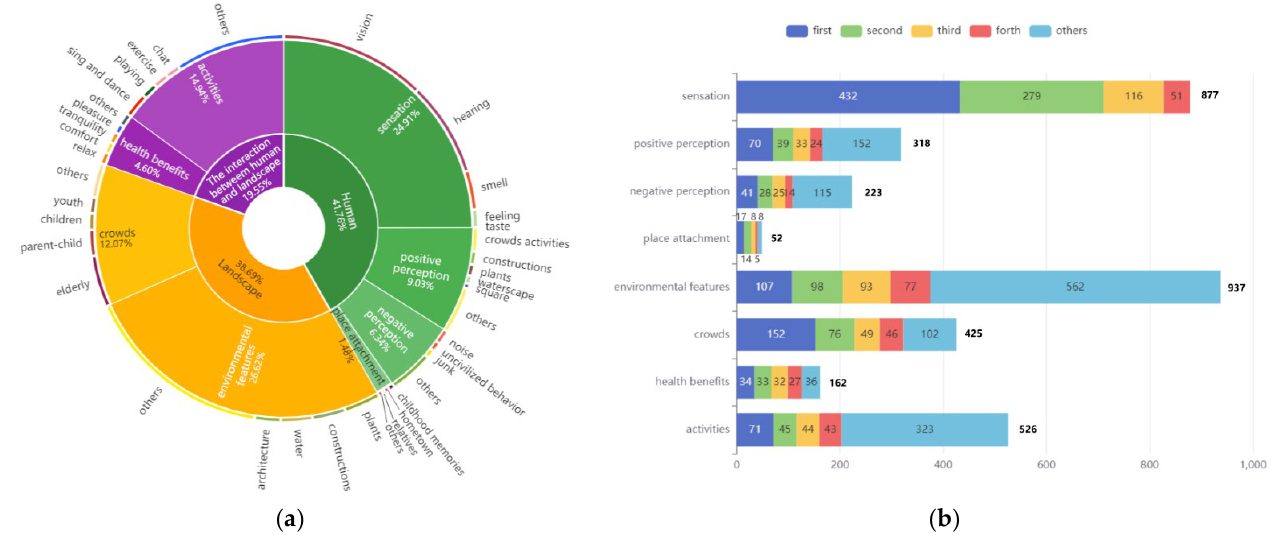
Figure 3. The proportion and frequencies of the young adult’s parks perception. ( a ) The overall proportion of the young adults’ park perception; ( b ) The frequencies of the young adult’s parks perception. The perceived frequencies are ranked from high to low, and the codes of high frequencies can be queried in Table 2, corresponding to this graph. Table 4. Young adults’ perception encoding table. The code number and proportion of the young adult’s parks perception for each dimension\theme\code, “#” stand for code number, ”%” stand for proportion, we chose the 4 codes with the most frequency for each theme to represent, and the rest were put into “others”.